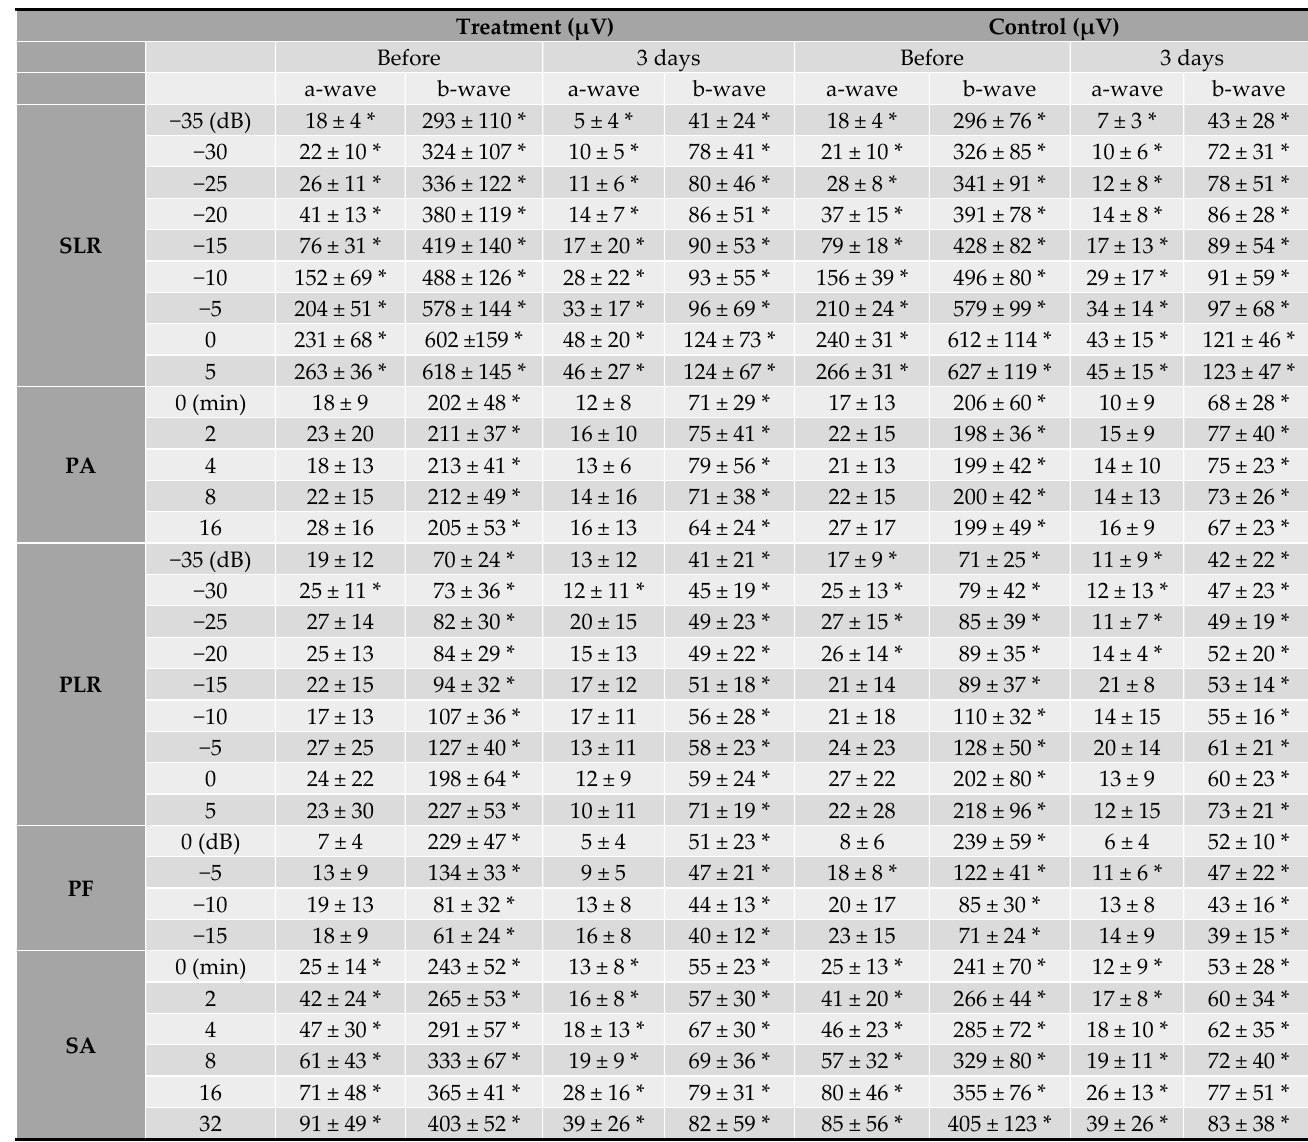
Table 2. ERG results from the OD: a-waves and b-waves recorded during the five ERG components. Results are presented as mean ± SD in microvolts ( µ V). ERGs were performed in the treatment and control groups, before glaucoma induction and again 3 days later.